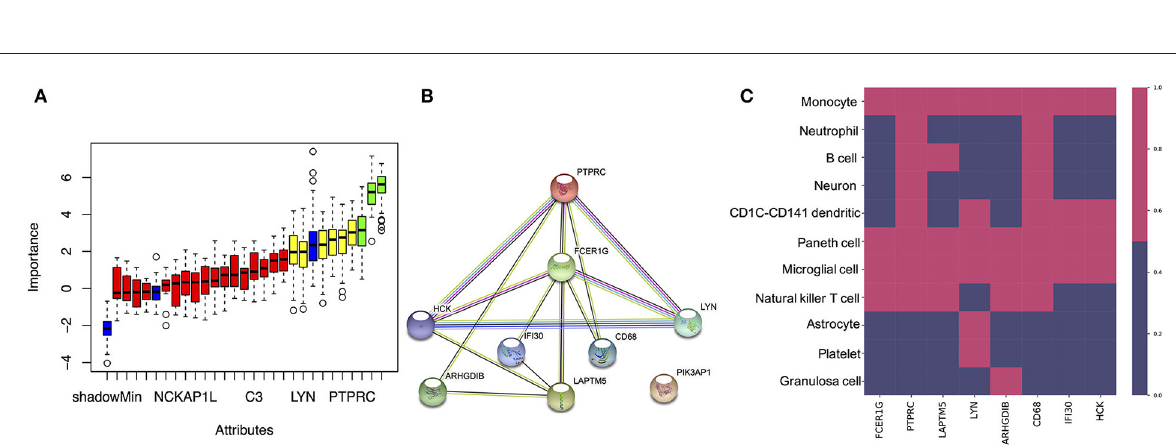
different from EC in the signal pathway of oxidative damage and A β